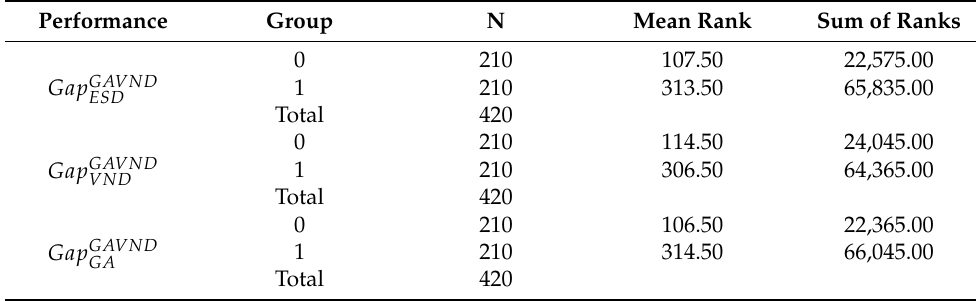
Figure 4. Performance of various heuristics. Table 5. Rank in the Wilcoxon rank-sum test.